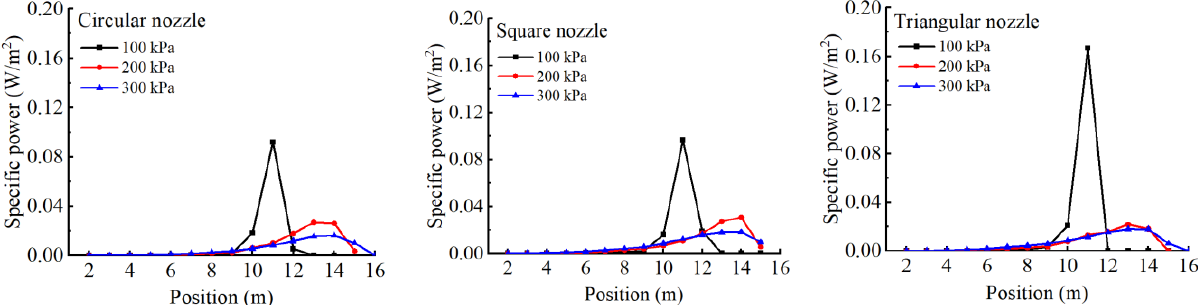
Figure 9. The specific power distribution along the spraying direction of three nozzle orifice shapes.